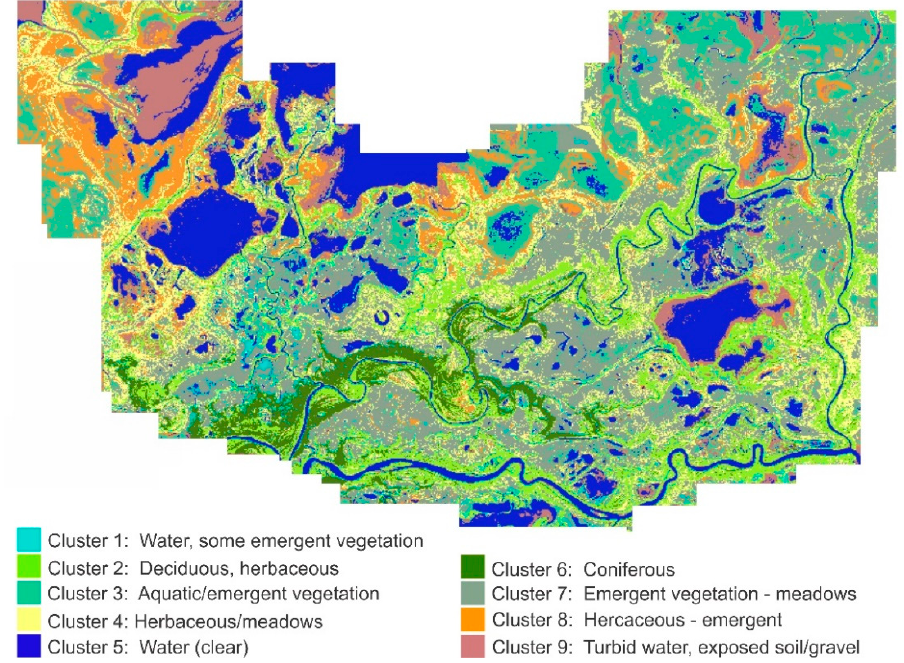
Figure 4. A spatial representation of the structural classes of the cover for the study area. Reproduced with permission from Peters et al. [18].